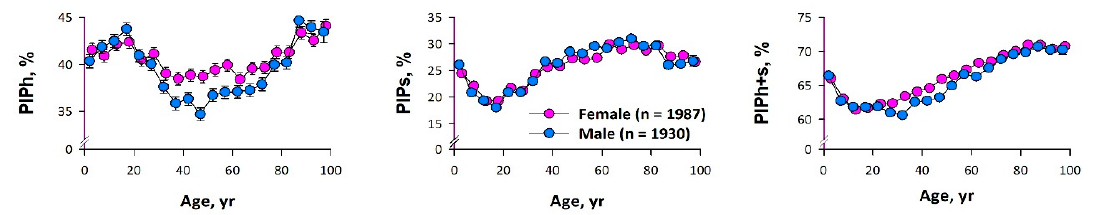
Figure 7. Age and sex dependency of the percentage of hard and soft inflection points (PIPh and PIPs). PIPh+s = PIP calculated for both hard and soft inflection points.